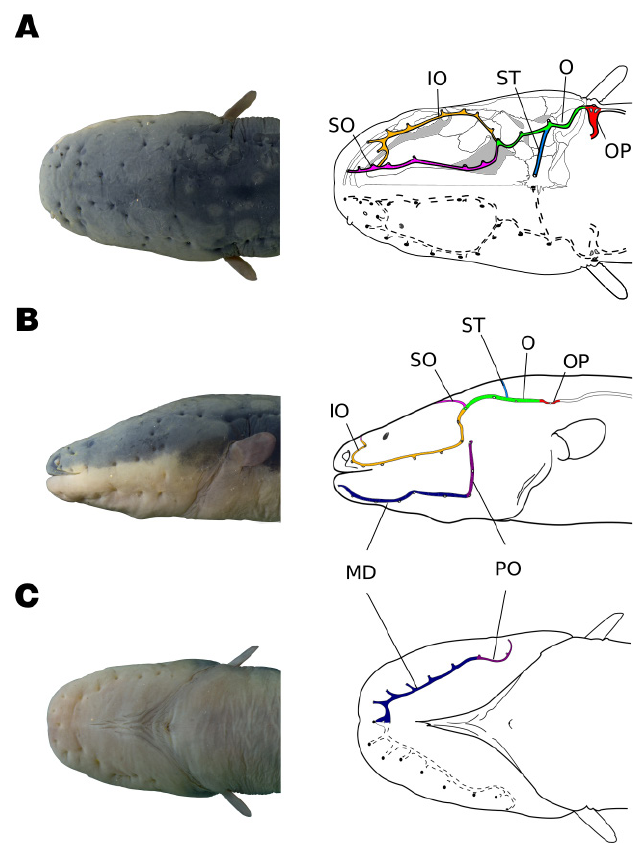
FIGURE 3 | Organization of the cephalic lateral-line canals in adult Electrophorus varii . Arrangement of all canals in A. dorsal, B. lateral and C. ventral views. Yellow: infraorbital canal; navy blue: mandibular canal; green: otic canal; purple: pre-opercular canal; pink: supraorbital canal; light blue: supratemporal canal; grey: posterior lateral-line canal of the trunk; red: otic pit (OP) between cephalic and trunk canals. The photographs are from a juvenile that completed the development and is morphologically similar to an adult. The drawings are from an individual of 148 cm